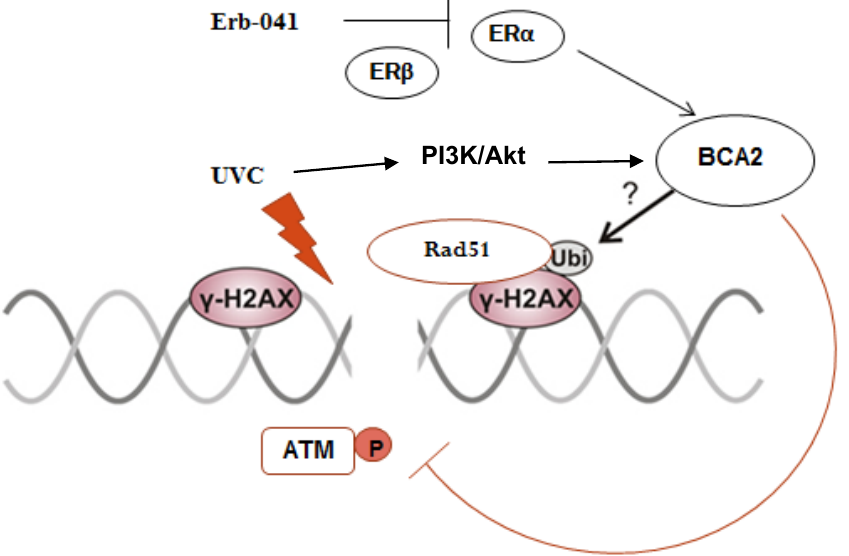
Figure 7. Proposed working model. In response to UVC, MCF-7 cells increase the ubiquitination activity and chromatin-binding ability of BCA2 through AKT-mediated BCA2 activation [28,38]. The association of BCA2 with γH2AX incites a BCA2/H2AX/ATM axis, initiating the DDR and controlling breast cancer cell sensitivity. The importance of Erb-041 in suppressing DNA recombination repair through BCA2 inhibition is based on the mitigatory effect of Erb-041 on AKT activation and ERα-mediated BCA2 transcription [4]. By pretreating MCF-7 cells with Erb-041, UV-induced chromatin-bound Rad51 and BCA2 became solubilized, leading to the abolition of DNA